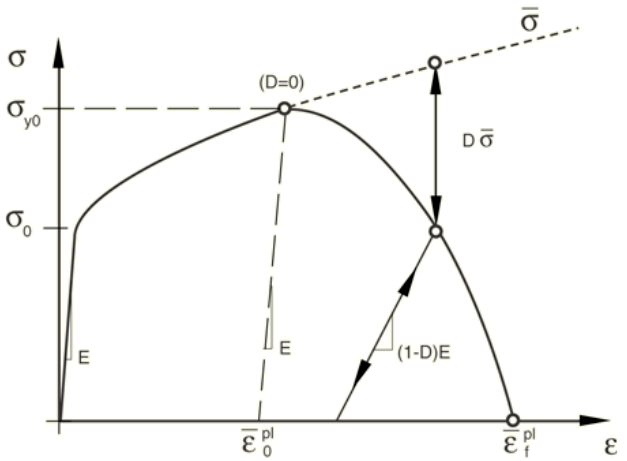
Figure 1. Stress-strain relationship with damage accumulation. With damage accumulation, critical equivalent plastic strain provokes damage initiation. After the onset of damage initiation, elastic modulus and strength are dramatically decreased.